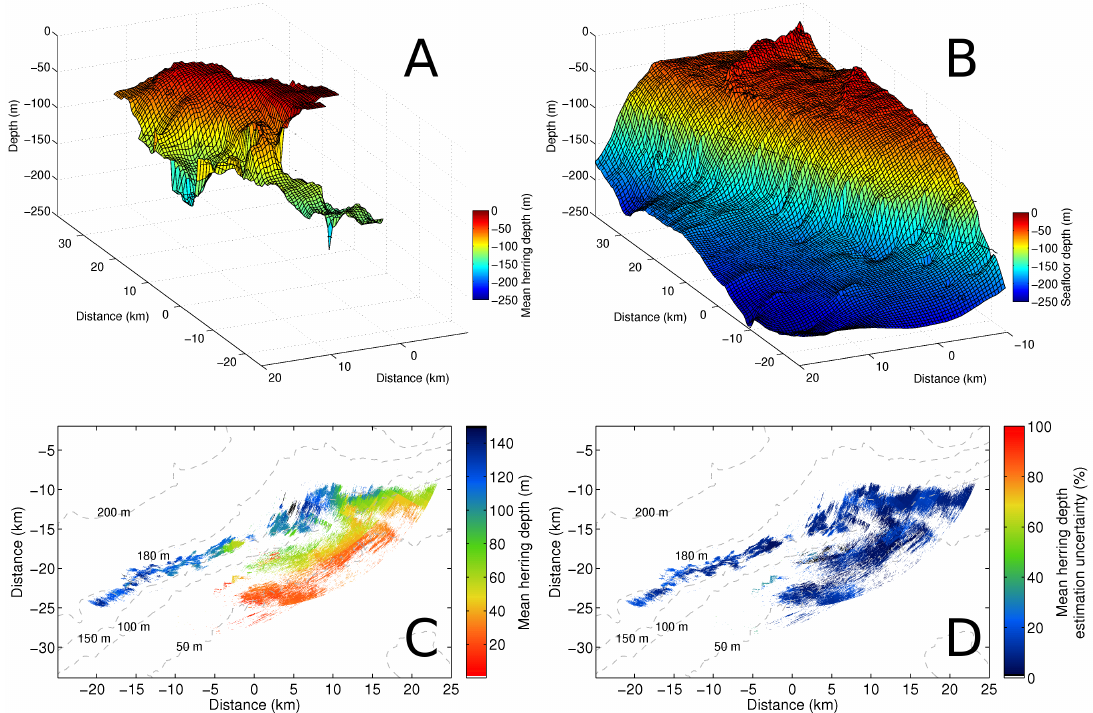
Figure 7. ( A ) 3D surface of mean herring group depth determined from multi-frequency measurements taken from 17:25:00 to 21:37:30 EDT on 29 September 2006; ( B ) seafloor depth of the sloping bottom on the northern flank of Georges Bank. The mean herring group depth and the seafloor depth are found to be highly correlated (0.9 correlation coefficient) for migratory paths along the bathymetric gradient; ( C ) the horizontal distribution of mean herring group depth; ( D ) estimation uncertainty for mean herring group depth in percentage determined by Equation (13). The rest of the estimated herring group parameters and corresponding estimation uncertainties are shown in Figure